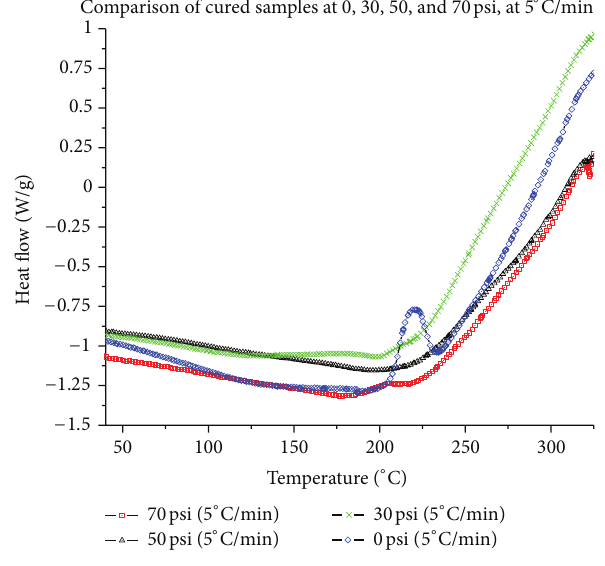
Figure 6: Eight plies samples comparison for the rate 5 ∘ C /min at 0, 30, 50, and 70 psi.